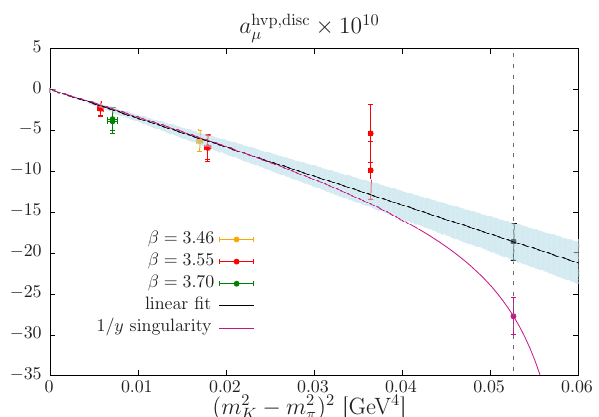
Figure 5. Results for the quark-disconnected contribution ( a hvp µ ) disc computed on a subset of our gauge ensembles. Extrap- olations to the physical mass are performed using two di ff erent ansätze in the fit.